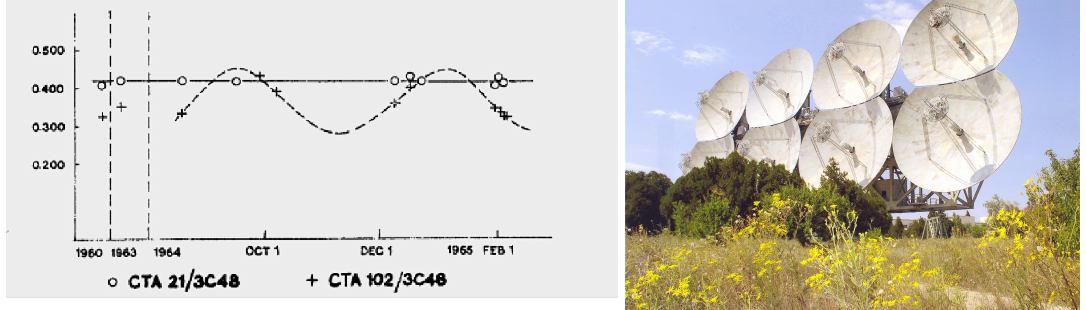
Figure 1. ( Left ) Sholomitskii’s published 32.5 cm variability data through February 1965 [5], reproduced with permission; ( Right ) A 1999 photo of ADU 1000, Sholomitskii’s original antenna (courtesy of L.